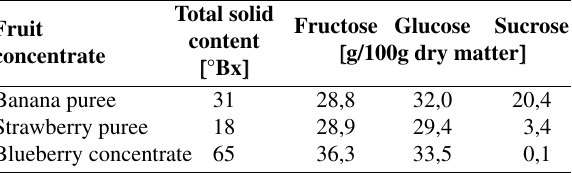
Table 6. – Sugar composition of fruit purees and concentrates